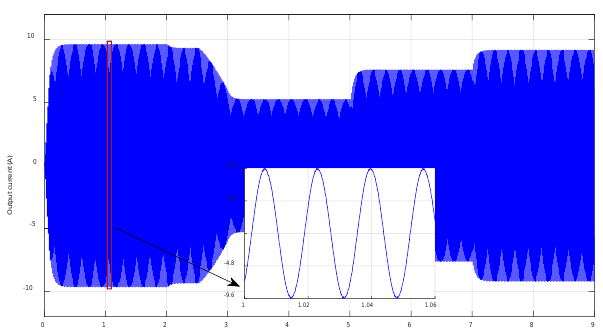
Figure 14. Output voltage.